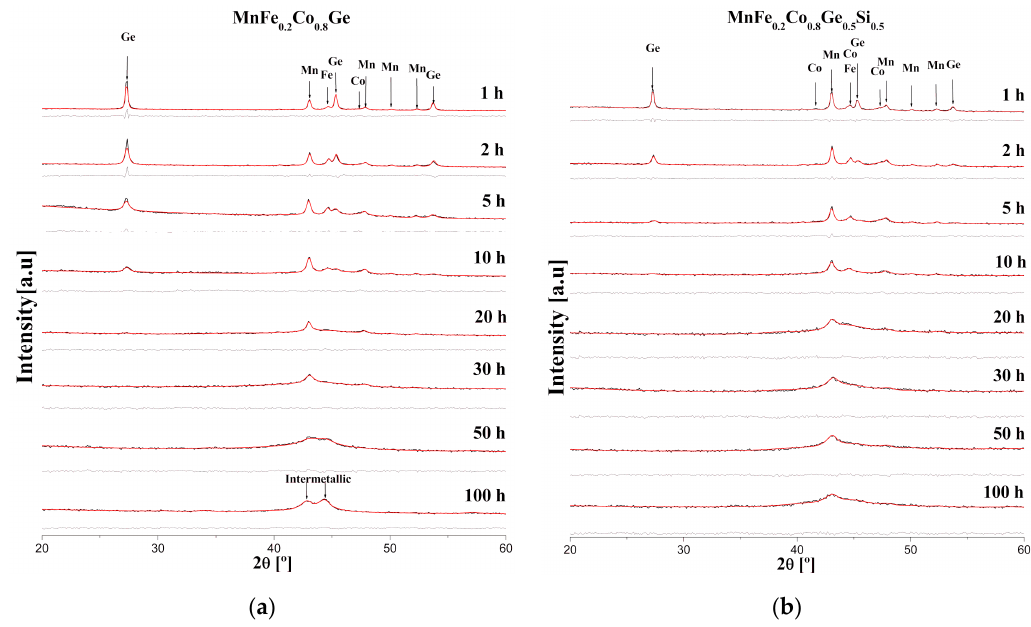
Figure 1. X-ray diffraction (XRD) patterns of samples after different times of milling: ( a ) Si-free alloy ( b ) Si-containing alloy. The corresponding differences between the experimental data and the Rietveld fittings are shown below each experimental pattern. The experimental data in black and the fitting in red.